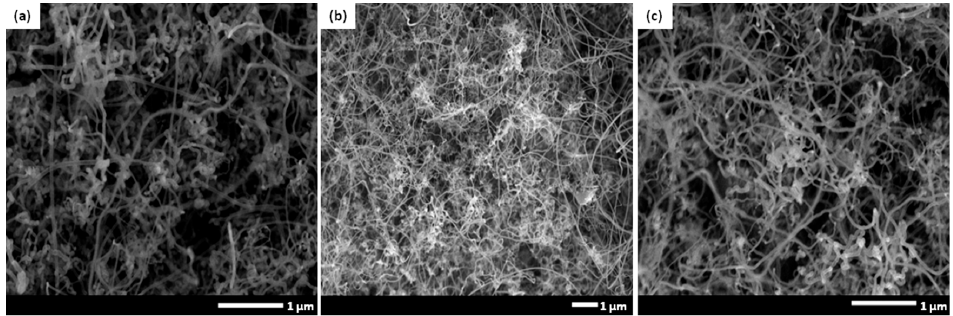
Figure 6. FE-SEM images of CNFs prepared with di ff erent ferrocene concentrations: ( a ) ferrocene (1.00 g), ( b ) ferrocene (2.21 g), ( c ) ferrocene (3.00